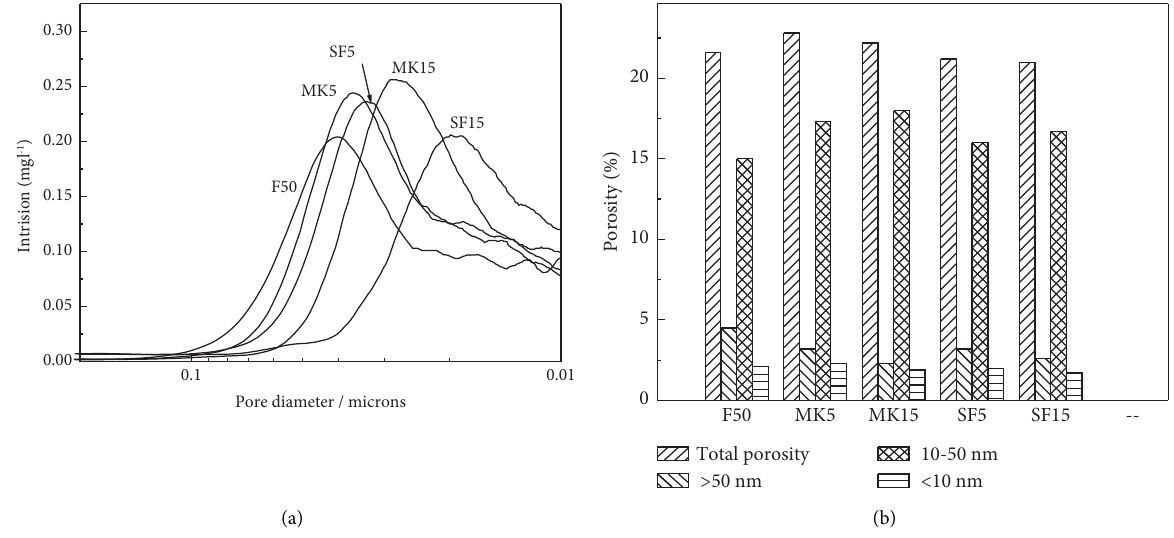
Figure 8: (a) Pore size distribution and (b) porosity of ternary cementitious system blended with MK and SF at 28